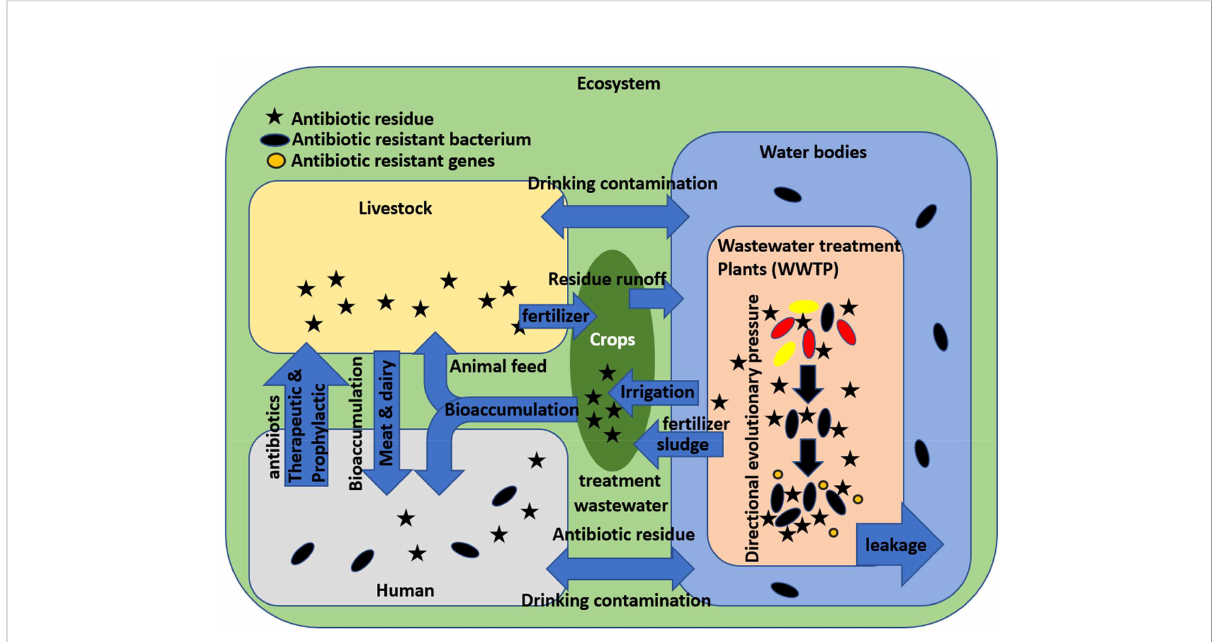
FIGURE 1 Ecological cycle of antibiotic resistance development in Escherichia coli and human